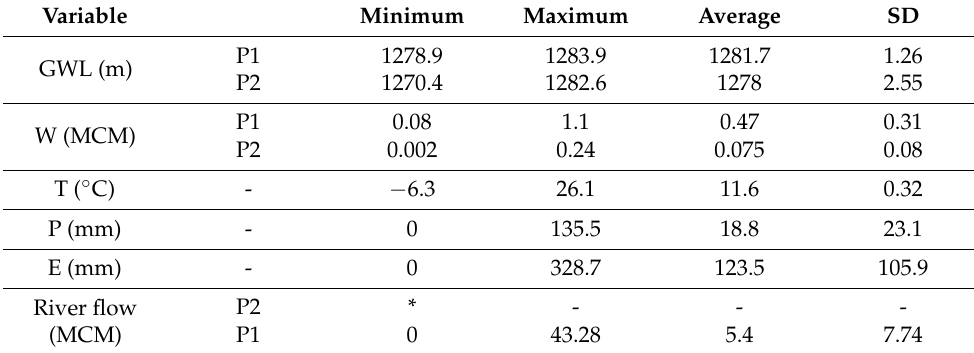
Table 2. Summary of used variables for GWL modeling (monthly data) *.